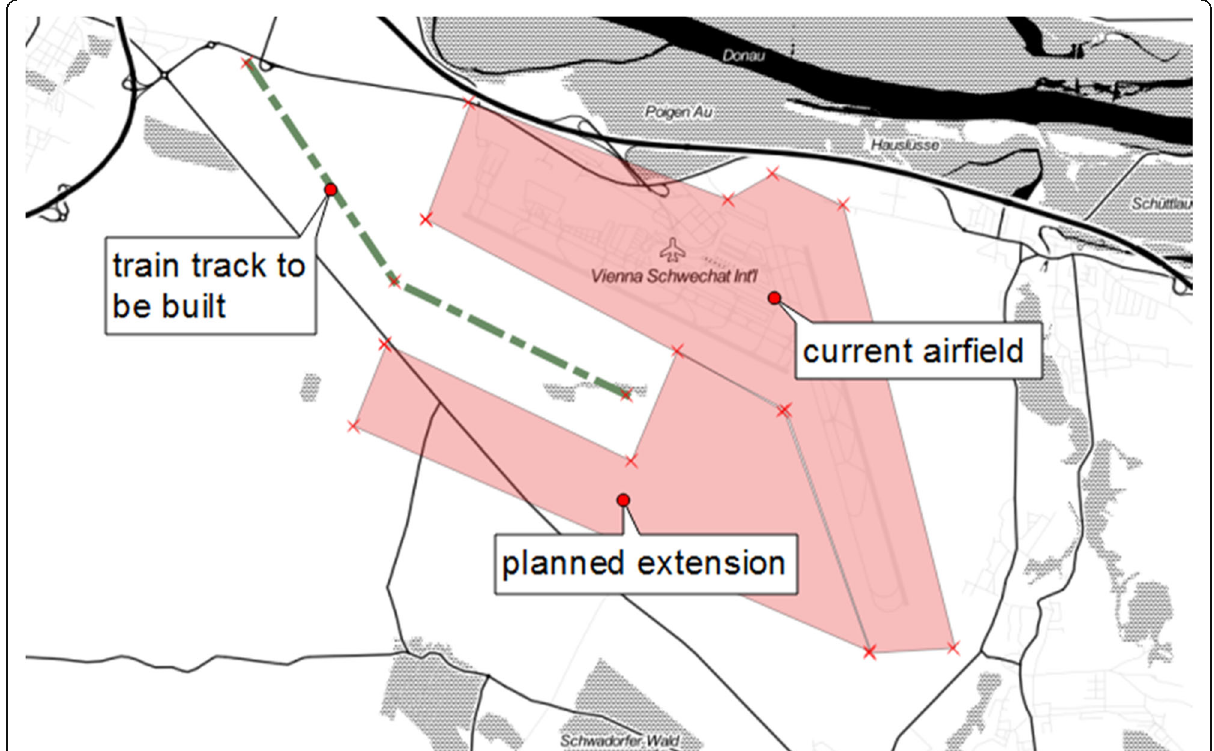
Fig. 2 Additional tracks and air cargo relocation for the rail connection